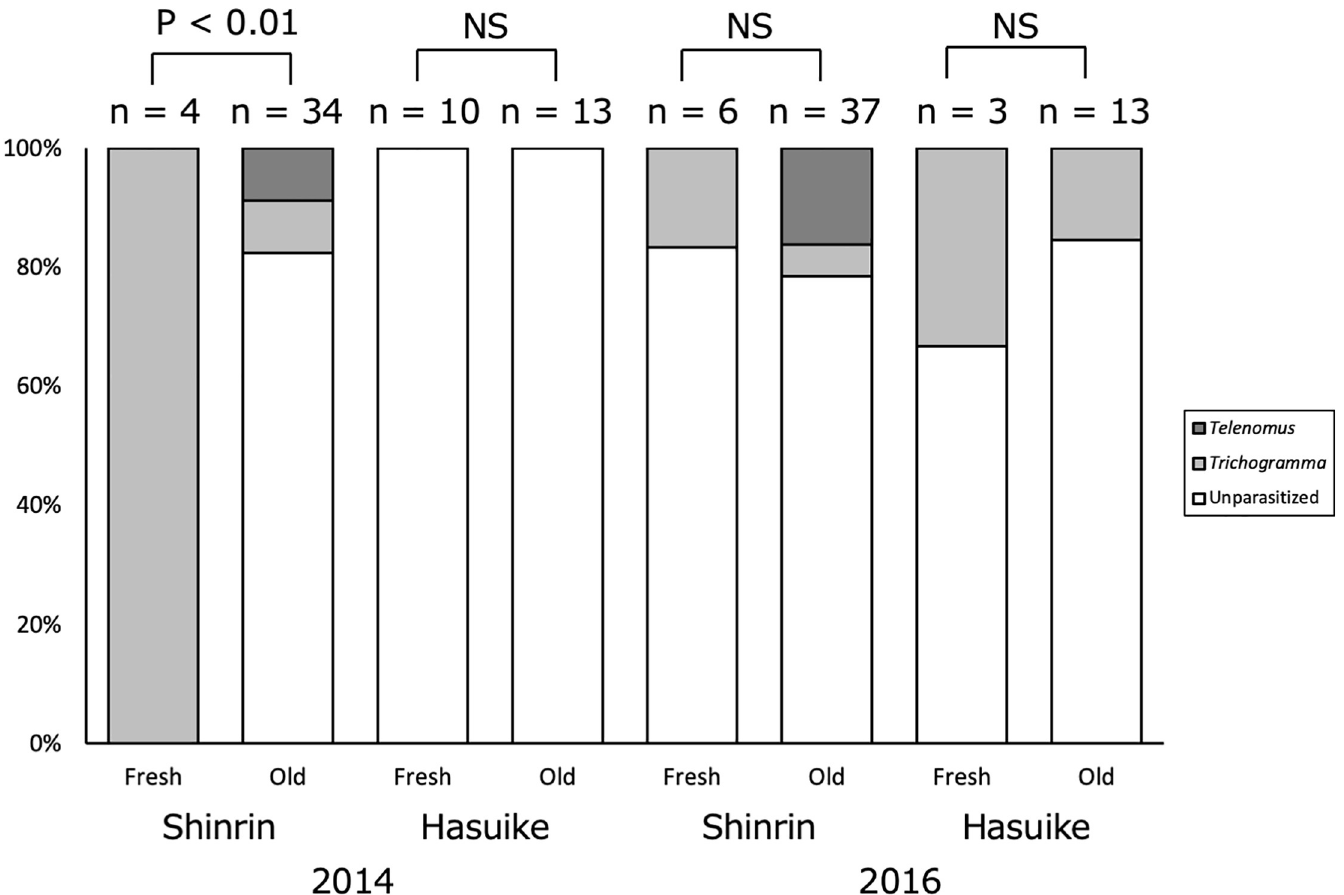
Fig 6. Percentages of A . bazalus eggs parasitized by Telenomus sp. and Trichogramma sp. on fresh and old L . edulis foliage collected from Shinrin Park and Hasuike Park, Saga, Kyushu, Japan in 2014 and 2016.